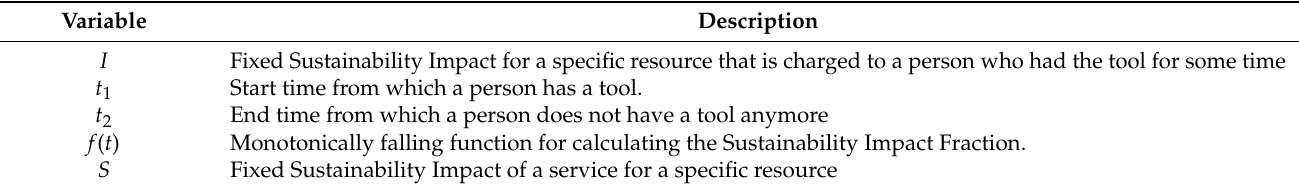
Table 1. Variables for Formula